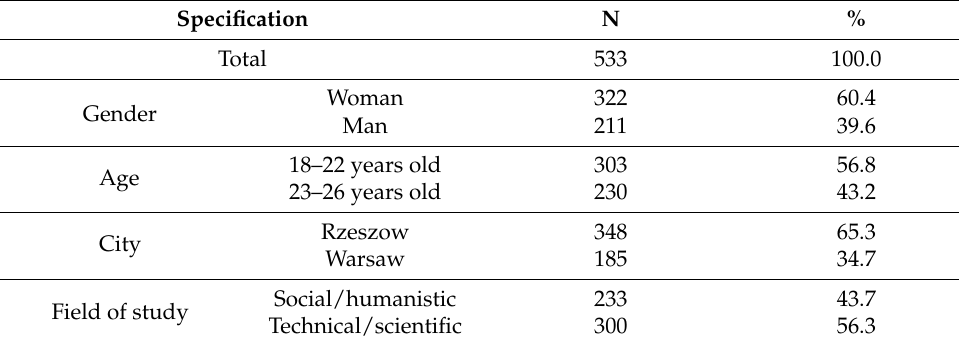
Table 1. The structure of the population under